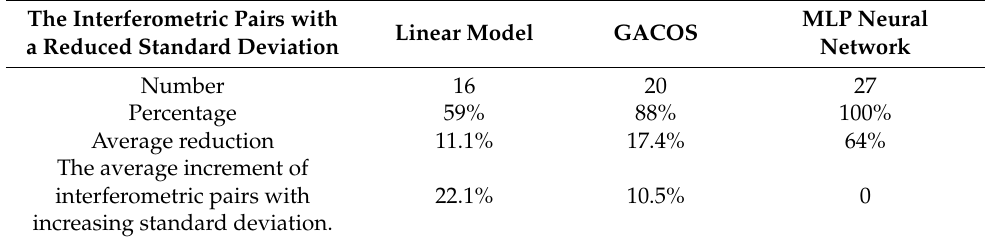
Figure 5. Changes in phase standard deviation before and after atmospheric correction by three methods. Table 3. The number of, percentage of, and average reduction in interference pairs with reduced phase standard deviation and average increment of interference pairs with increased phase standard deviation of the interferogram after the correction using the three correction